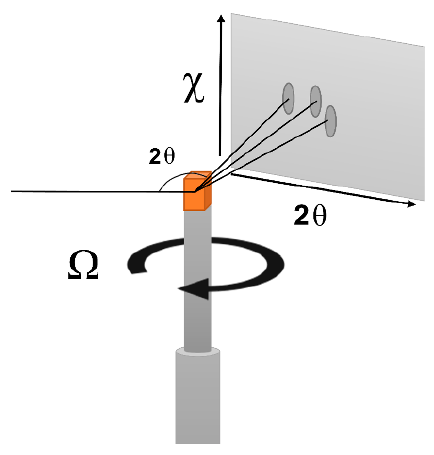
Figure 1. Schematic of the goniometer setup on Beamline E3 at HZB.